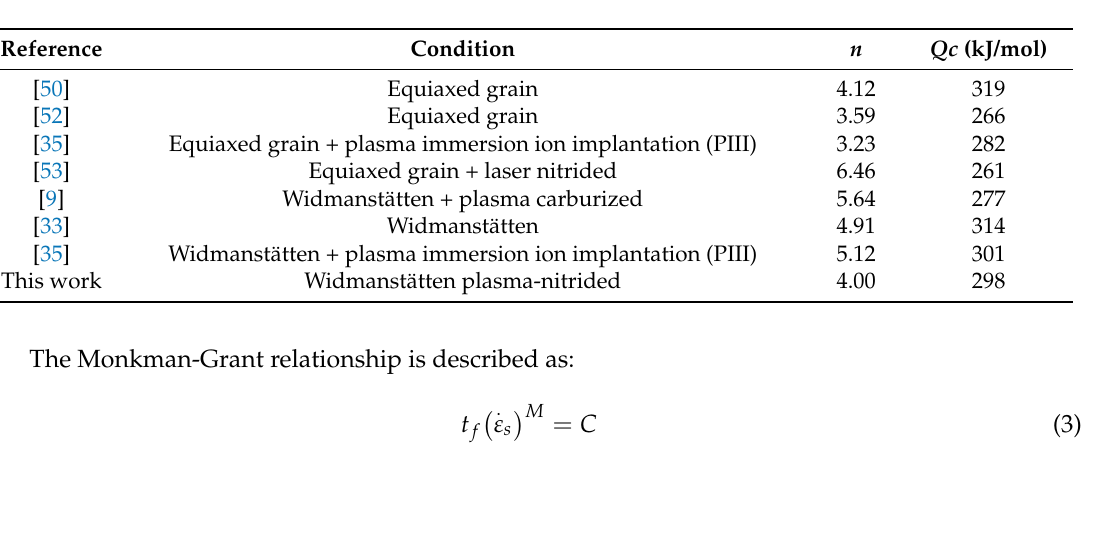
Table 5. Values of the stress exponent from secondary creep ( n ) and activation energy ( Qc ) for Ti-6Al-4V